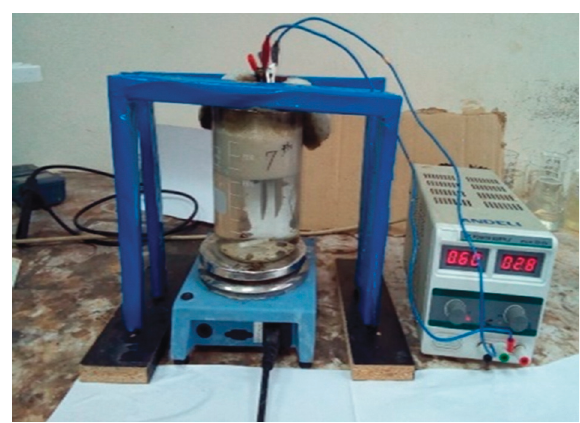
Figure 1: Experimental setup of the treatment